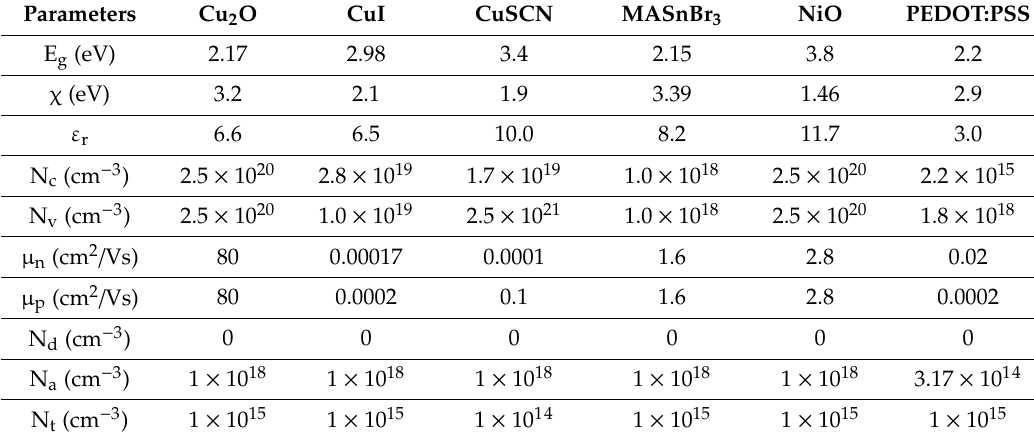
Table 3. Input parameters for di ff erent HTL